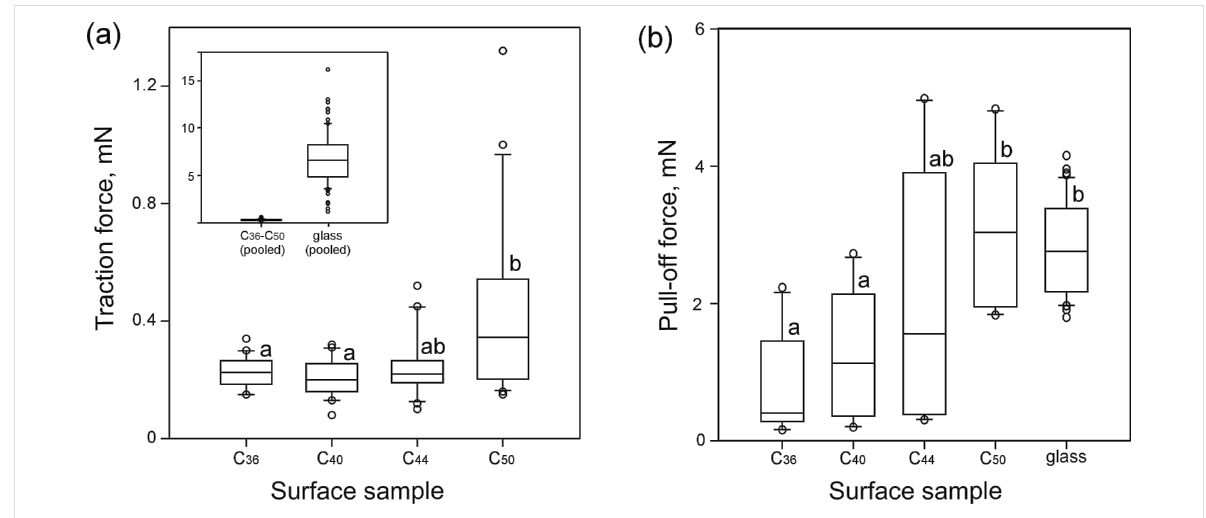
Figure 3: Traction forces of male beetles Coccinella septempunctata (a) and pull-off forces of PDMS semi-spheres (b) on different surfaces. According to the t -test and Mann–Whitney rank sum test (Table 3 and Table 4), means/medians with different letters differ significantly from each other.